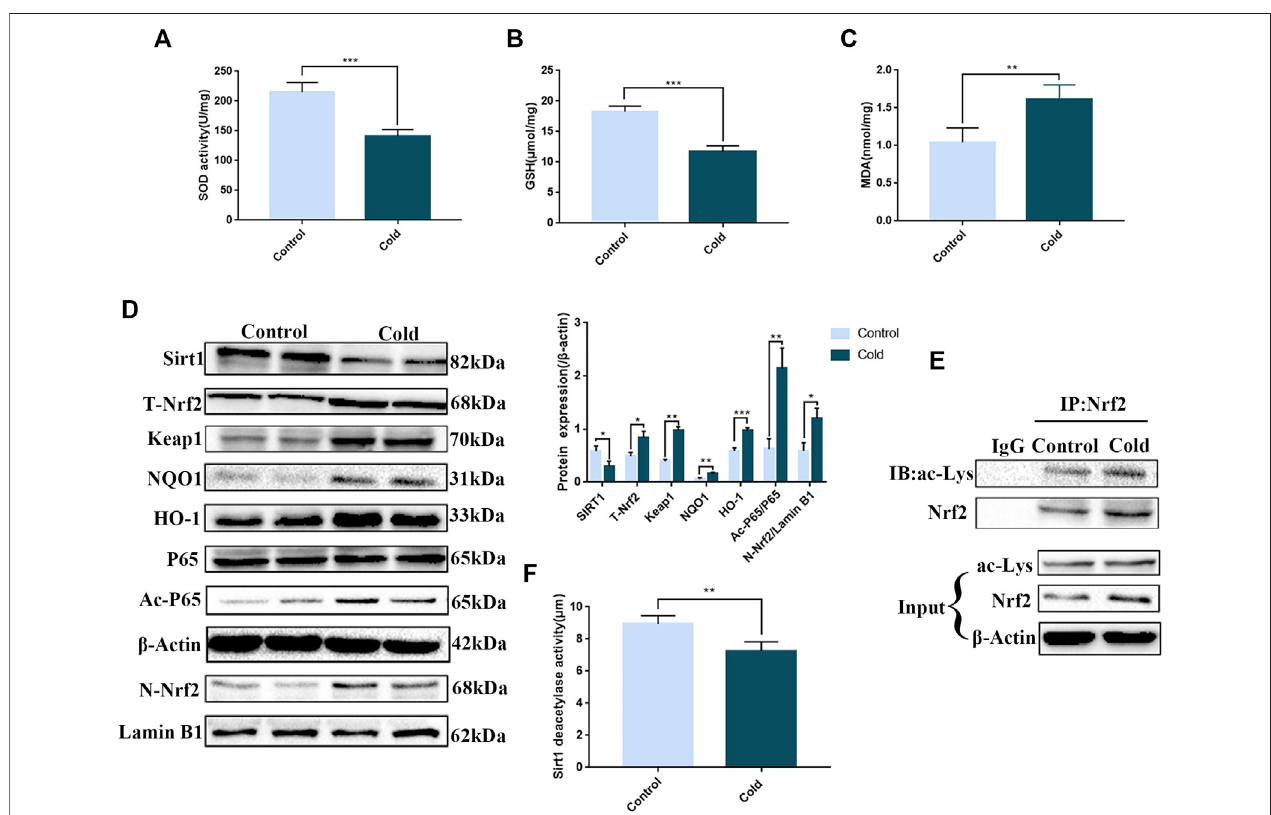
FIGURE 3 | Cold exposure induces oxidative stress in the colon and regulates SIRT1/Nrf2-and SIRT1/NF- κ B-mediated pathways in vivo . Effects ofcold exposure onSOD (A) ,GSH (B) andMDA (C) levelsinthemousecolon.Theproteinexpressionlevels (D) andenzymeactivity (F) ofSIRT1. (D) Theproteinexpressionlevelsoftotal- Nrf2,Keap1, nuclear-Nrf2, NQO1, HO-1, p65, and acetylated-p65 were measured by western blot analysis in mouse colon tissue. (E) The acetylation level of Nrf2 was determined using co-immunoprecipitation assays in mouse colon tissue. Data are presented as the mean ± SEM ( n = 3). Statistically signi fi cant differences are